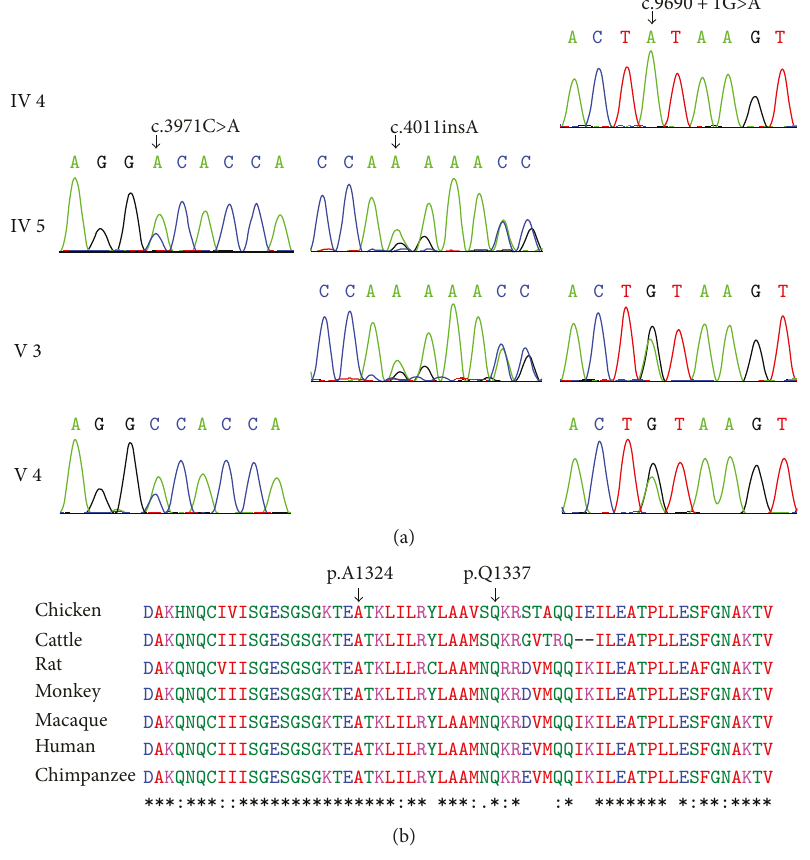
Figure 2: Sequence chromatograms and protein alignment. (a) The sequences of MYO15A at 3971, 4011, and 9690 +1 of four family members. (b) The conservation of the p.A1324 and p.Q1337 residues (shown with black arrows) in healthy human, rat, chicken, chimpanzee, monkey, cattle, and macaque. Table 2: Genotypes of all family